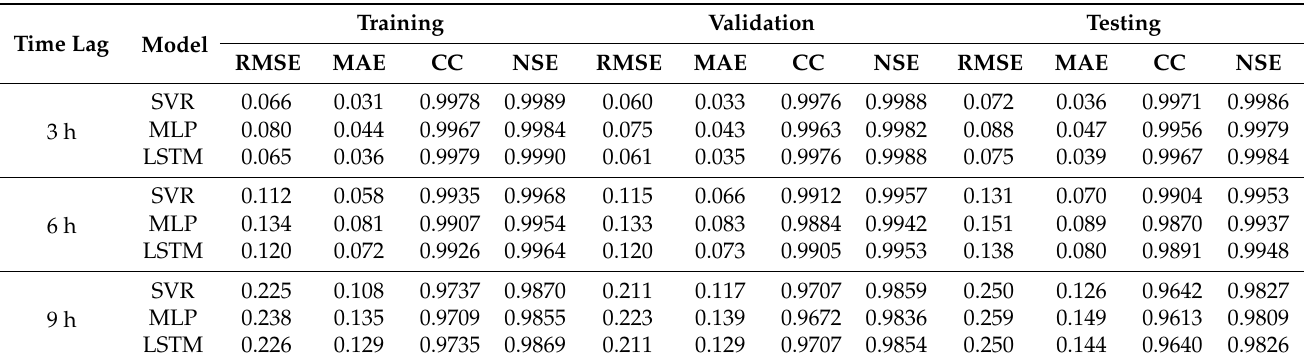
Table 3. Comparison of ML models’ performance for training, validation, and testing dataset. The units of RMSE and MAE are